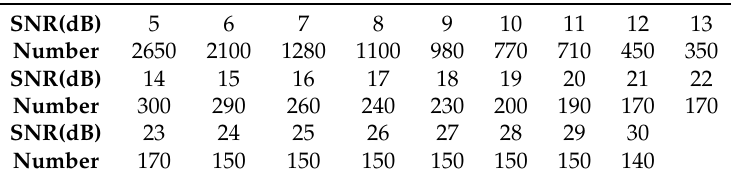
Table 4. Maximum number of received symbols for different